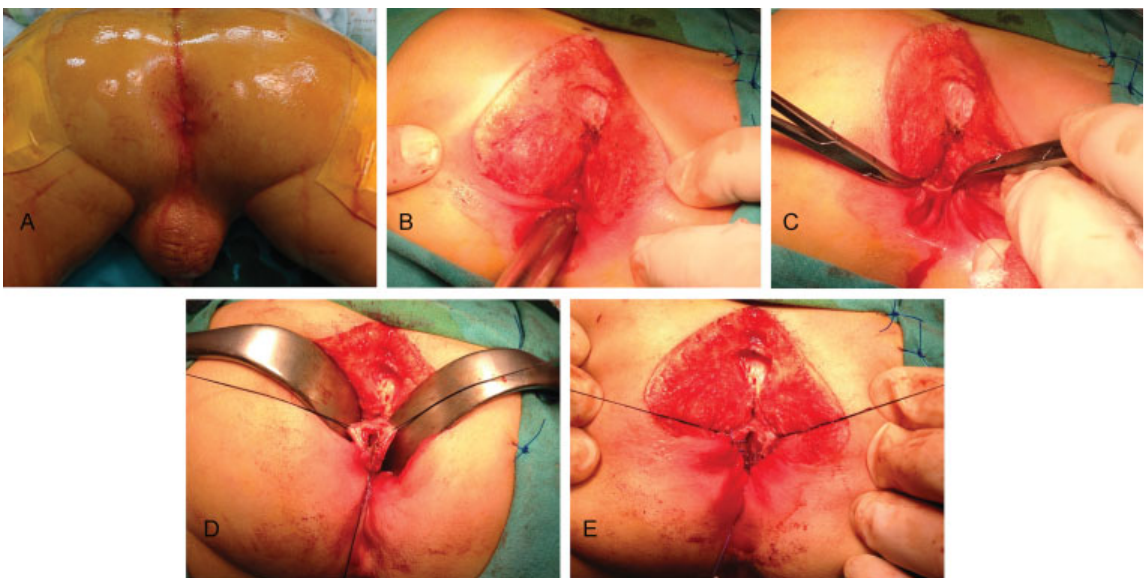
Fig. 2 ( A ) Intraoperativeimageshowing the patient inapronepositionwiththepelviselevatedfor theposterior sagittalapproach. The patient exhibited normal perineum, genitalia, and a normally located anal opening. ( B ) Exposure of the defect with a Hegar dilator in the distal pouch. ( C ) The fi brous tissue separatingthetworectalpouches(theincisionasymmetryisduetotheasymmetricpositionof theinstrument).( D )Theupperpouchof therectumisheld with sutures and opened. ( E ) A simple end-to-end circumferential anastomosis with interrupted long-term absorbable